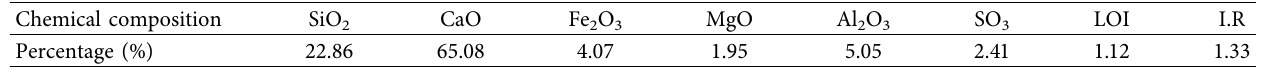
Table 1: Chemical composition of cement.